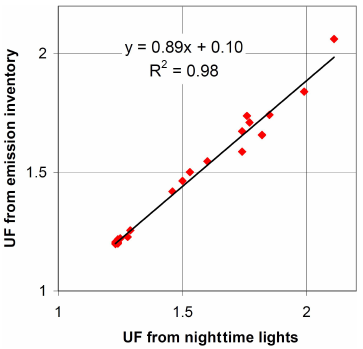
Figure 10. Upscaling factors (UF) based on the distribution of the NO x emissions are plotted as a function of the upscaling factor based on nighttime